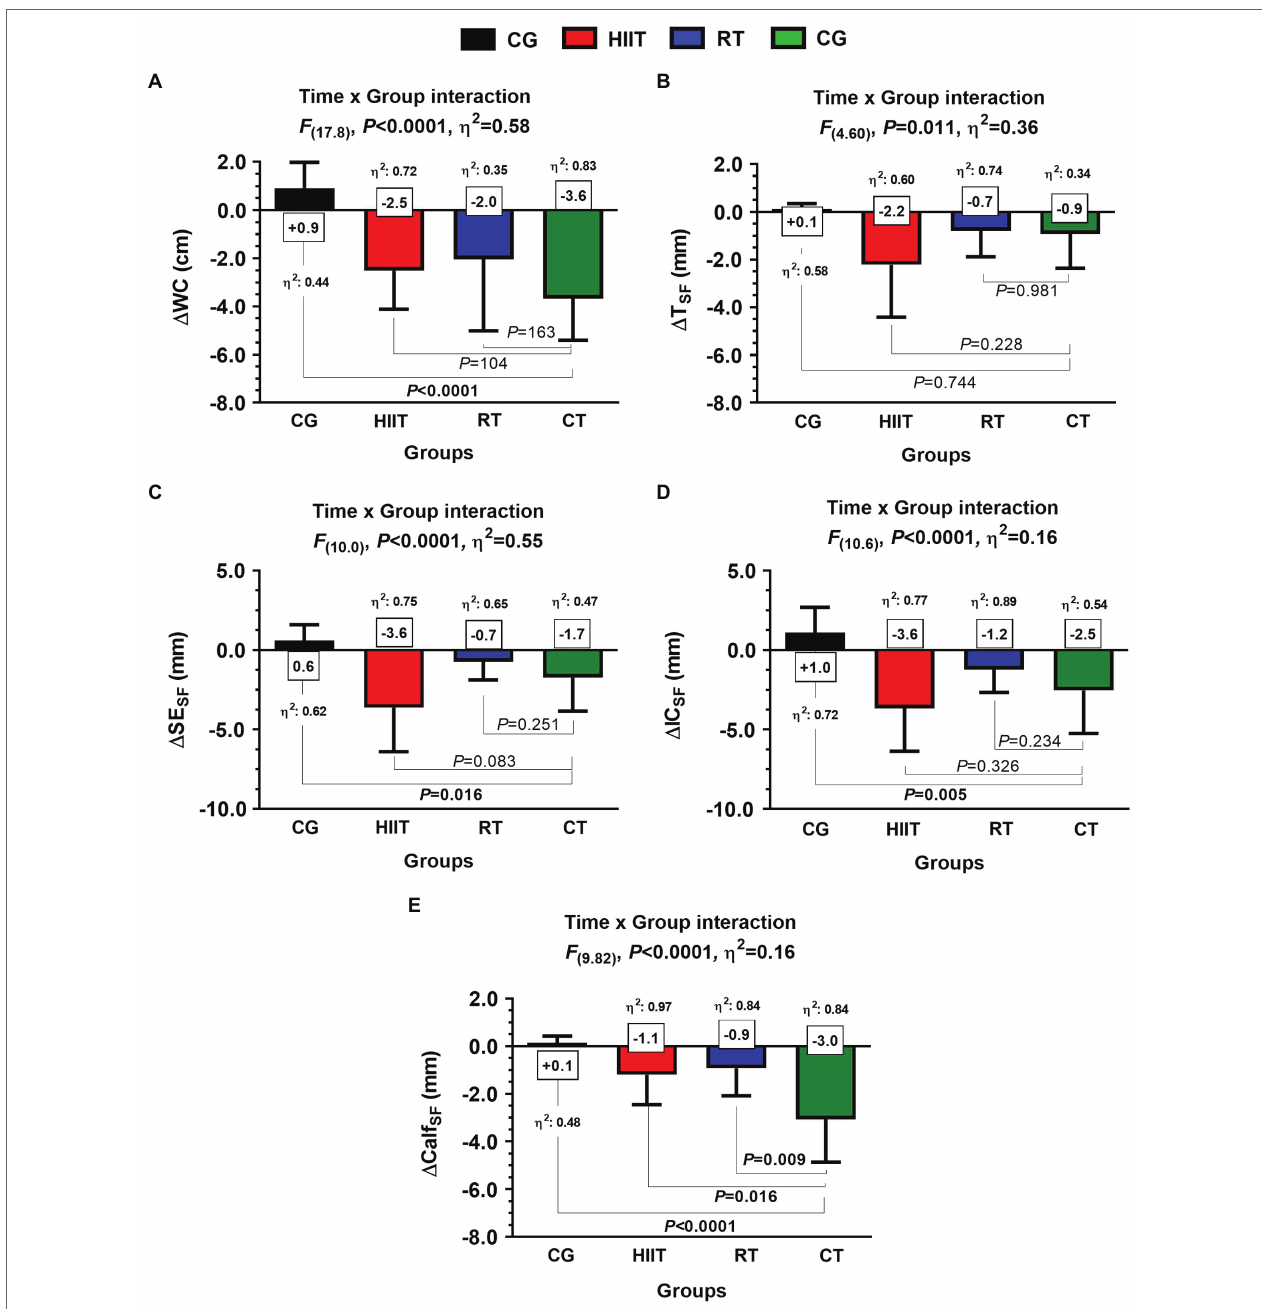
FIGURE 5 | Adaptations of adiposity markers after 12-weeks of three different exercise training programs, or in a control group, in adult women with insulin resistance. Groups are described as: control group (CG), high-intensity interval training (HIIT), resistance training (RT), and concurrent training (CT). Outcomes are described as delta waist circumference ( ∆ WC), delta tricípital skinfold ( ∆ T SF ), delta subscapular skinfold ( ∆ SE SF ), delta ilio-cristale skinfold ( ∆ IC SF ), and delta calf skinfold ( ∆ Calf SF ). Panel A show waist circumference, panel B tricícital skinfold, panel C subescapular skinfold, panel D ilio-crestale skinfold, and panel E calf skinfold. Between- group differences are described in bold values from panels (A–E) . η 2 denotes effect